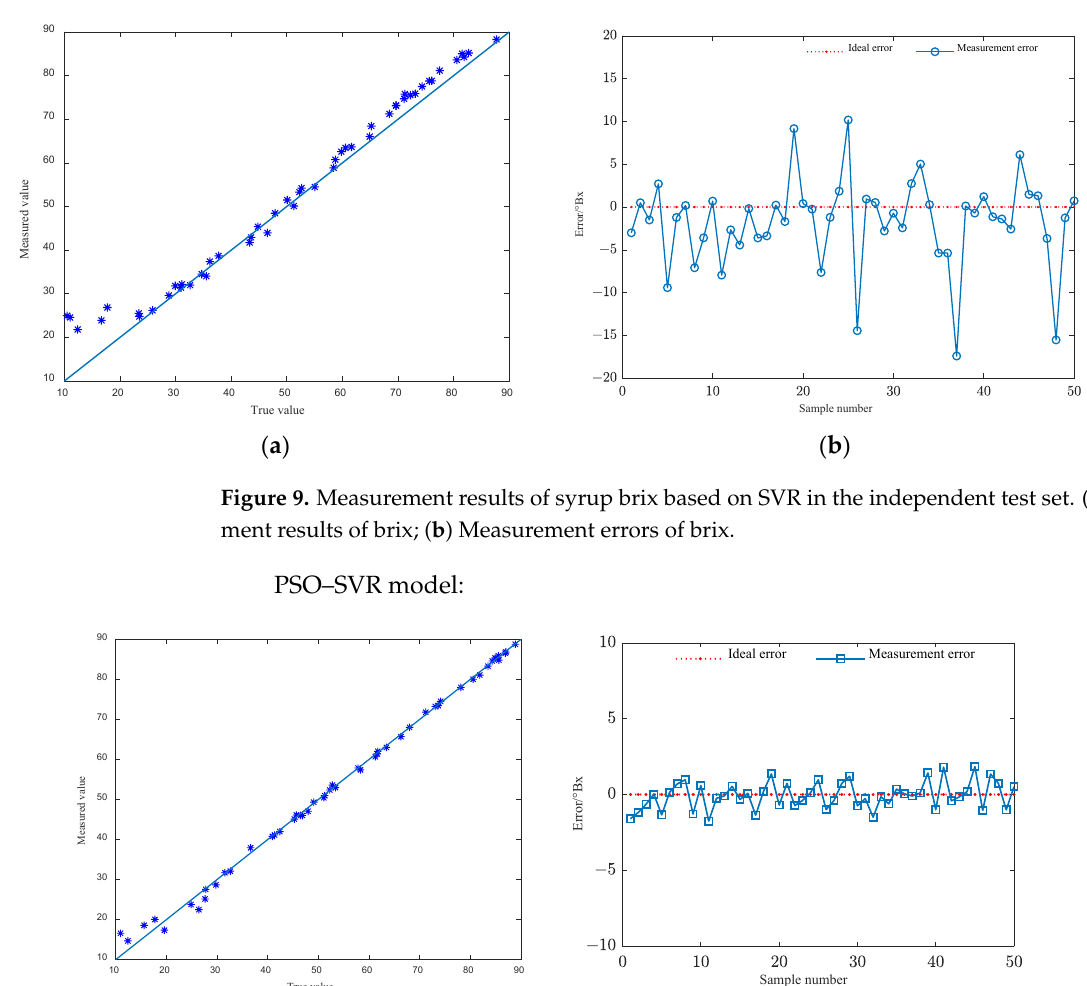
Table 6. Evaluation index of syrup brix measurement based on SVR and PSO–SVR.